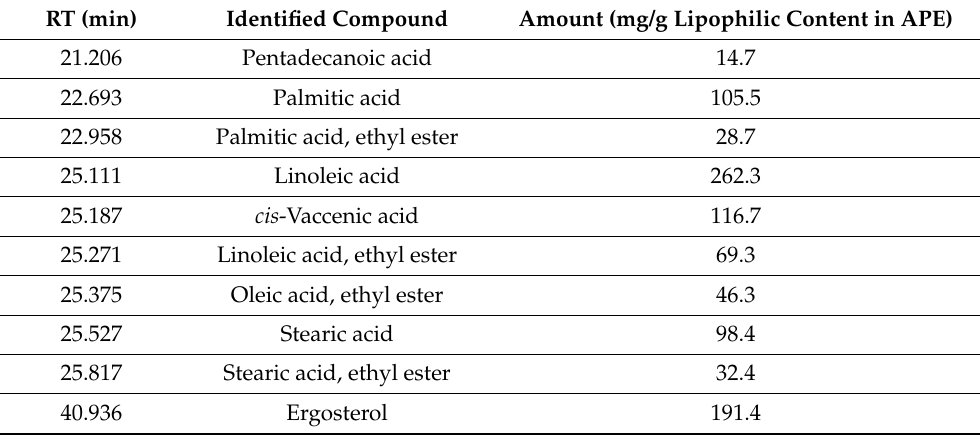
Figure 9. Analysis of lipophilic compounds in the AP crude extracts. ( a ) Thin-layer chromatography (TLC) of APH and APE was developed in hexane and ethyl acetate at a ratio of 8:2. The results were observed under UV light at 254 nm and 365 nm wavelengths. ( b ) Gas chromatogram of APE crude extracts analyzed by GC/MS. Table 3. Lipophilic compounds of APE crude extract analyzed by